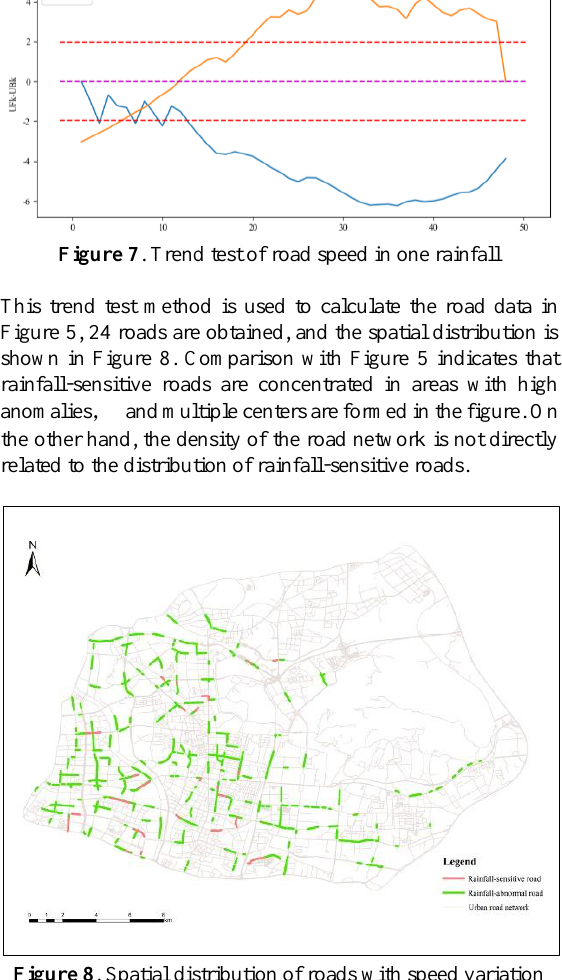
Figure 8 . Spatial distribution of roads with speed variation